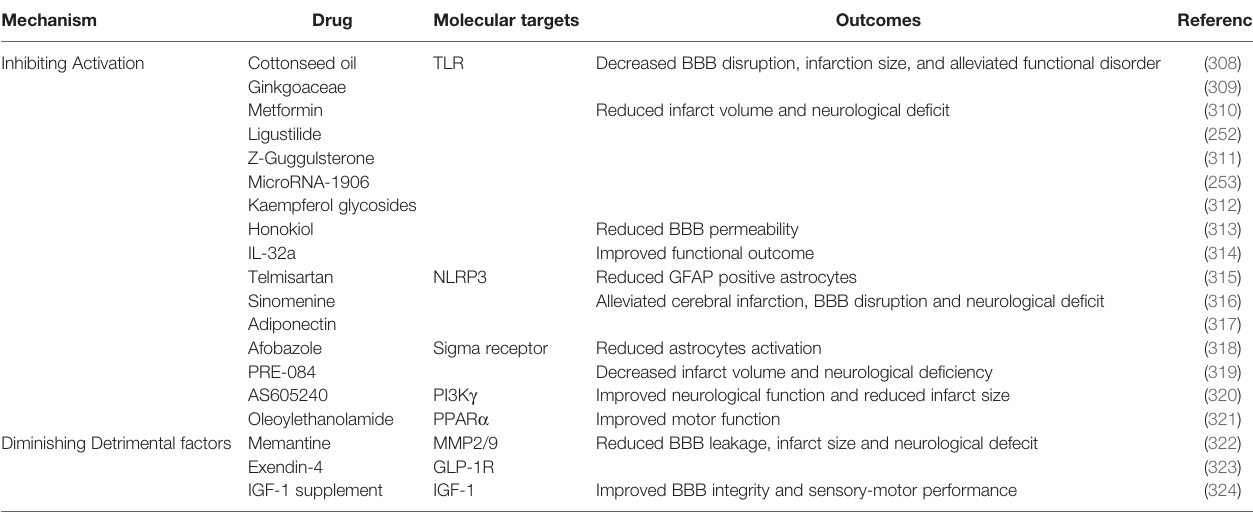
TABLE 5 | Preclinical attempts to target astrocytes for treating